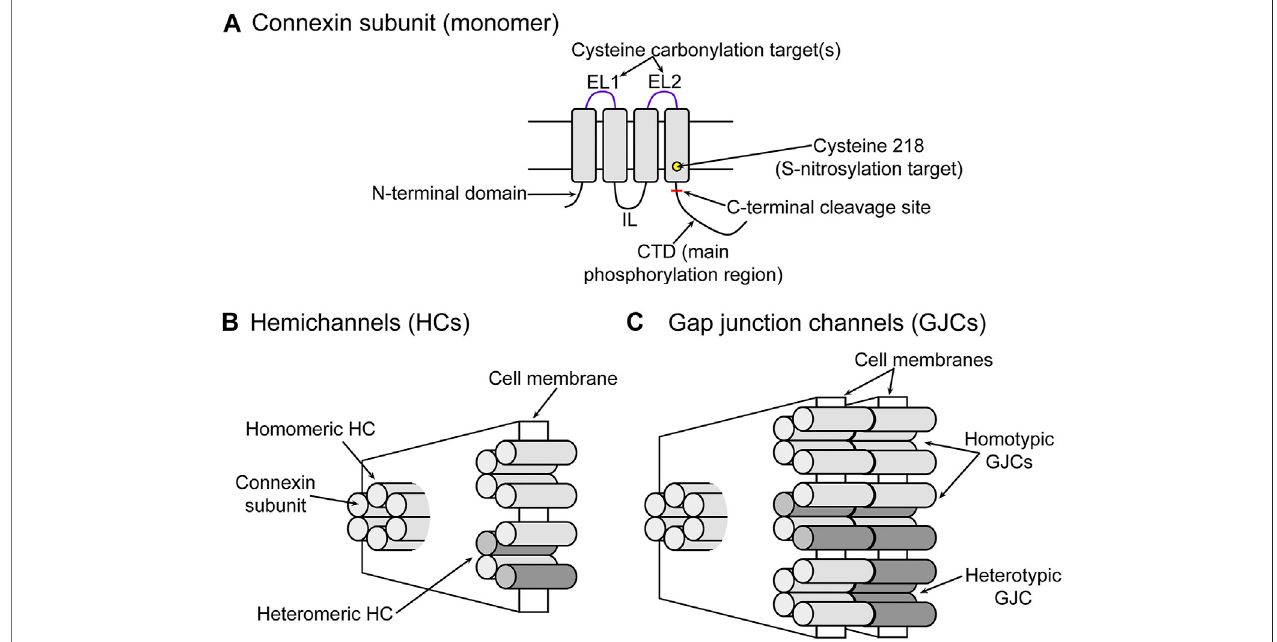
FIGURE 1 | Connexins, hemichannels and gap junction channels. (A) Schematic representation of a connexin subunit. EL1 and EL2, extracellular loops; IL, intracellular loop; CTD, C-terminal domain. The rectangle blocks represent transmembrane helices 1 – 4. The location targets of some of the posttranslational modi fi cations discussed in the text (phosphorylation, S-nitrosylation and carbonylation) are indicated. (B) Schematic representation of a connexin hemichannel. Each cylinder corresponds to a connexin subunit as seen in panel (A) . The two different tones represent different connexin isoforms (e.g., Cx46 and Cx50) and indicate hemichannels formed by only one isoform (homomeric) or more than one (heteromeric). (C) Schematic representation of a gap junction channel. Gap junction channels can be formed by docking of two hemichannels of the same subunit composition (homotypic) or hemichannels of different composition (heterotypic).